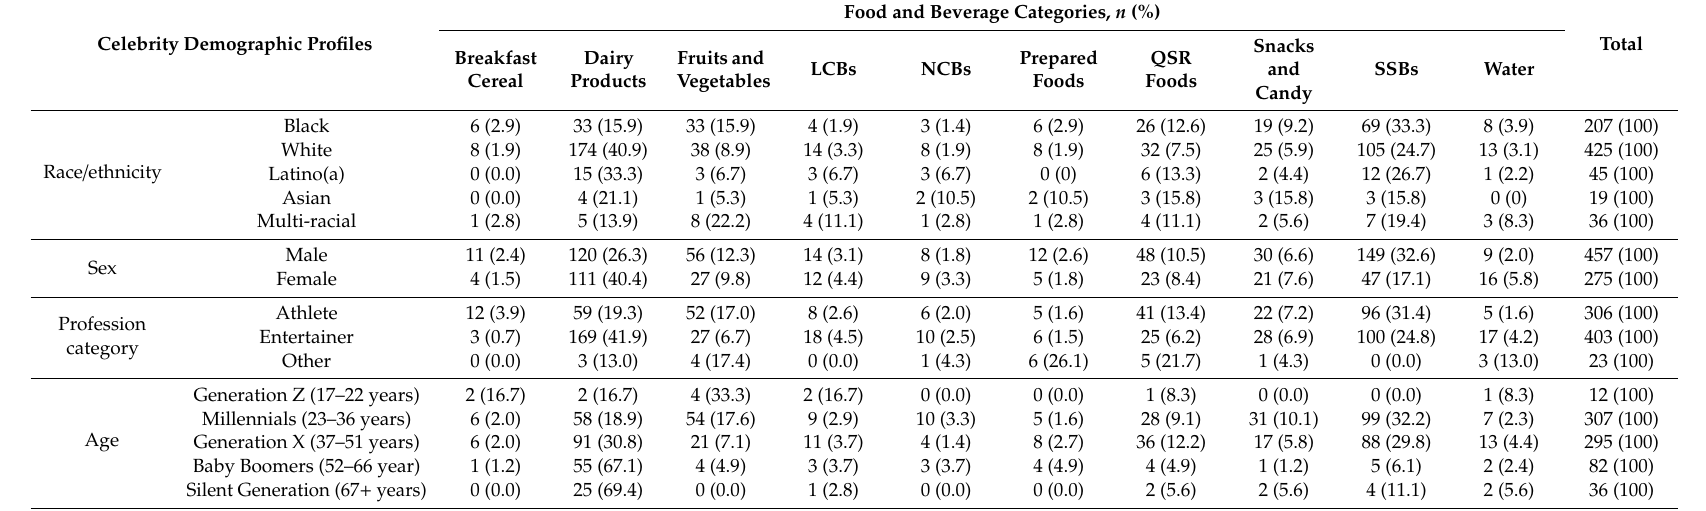
Table 4. Associations between celebrity demographic profiles and food and beverage category endorsements ( n =